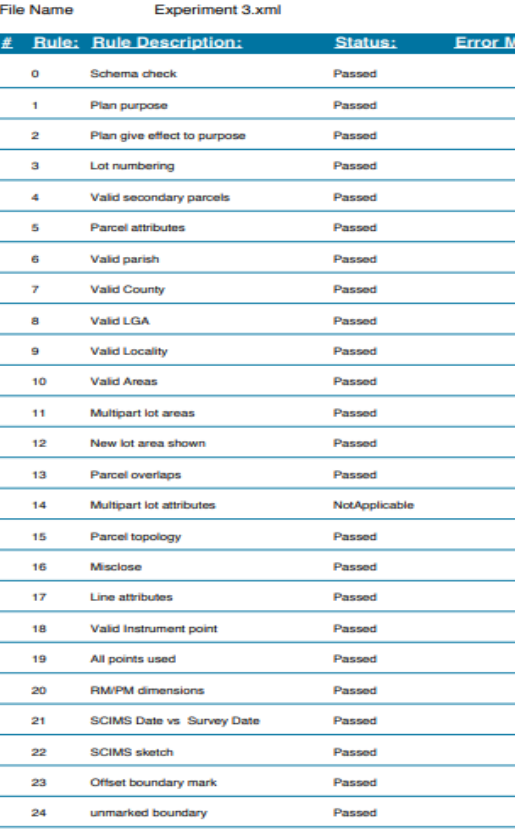
Figure 8: Validation Results Table The different rules have all been met and satisfied by the automatic checking. This ensures less human error when manual checks were done and accelerated the checking process.